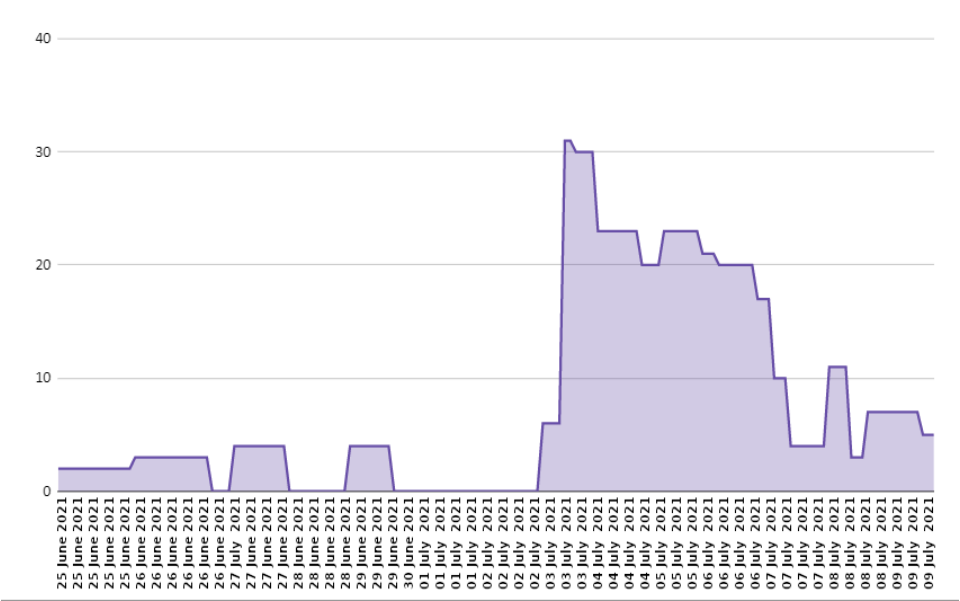
Figure 5. Price difference between Lufthansa prices and their